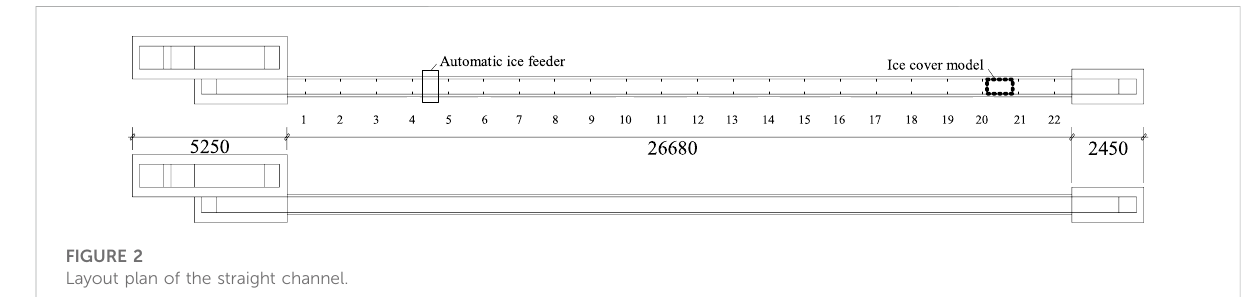
FIGURE 2 Layout plan of the straight channel.